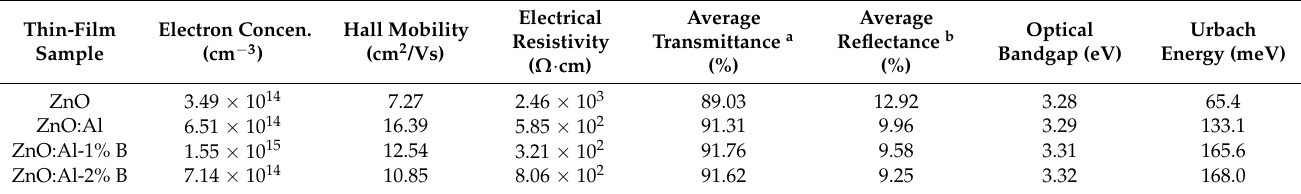
Table 2. Comparison of electrical and optical properties between ZnO, ZnO:Al and ZnO:Al-B thin films. Thin-Film Sample